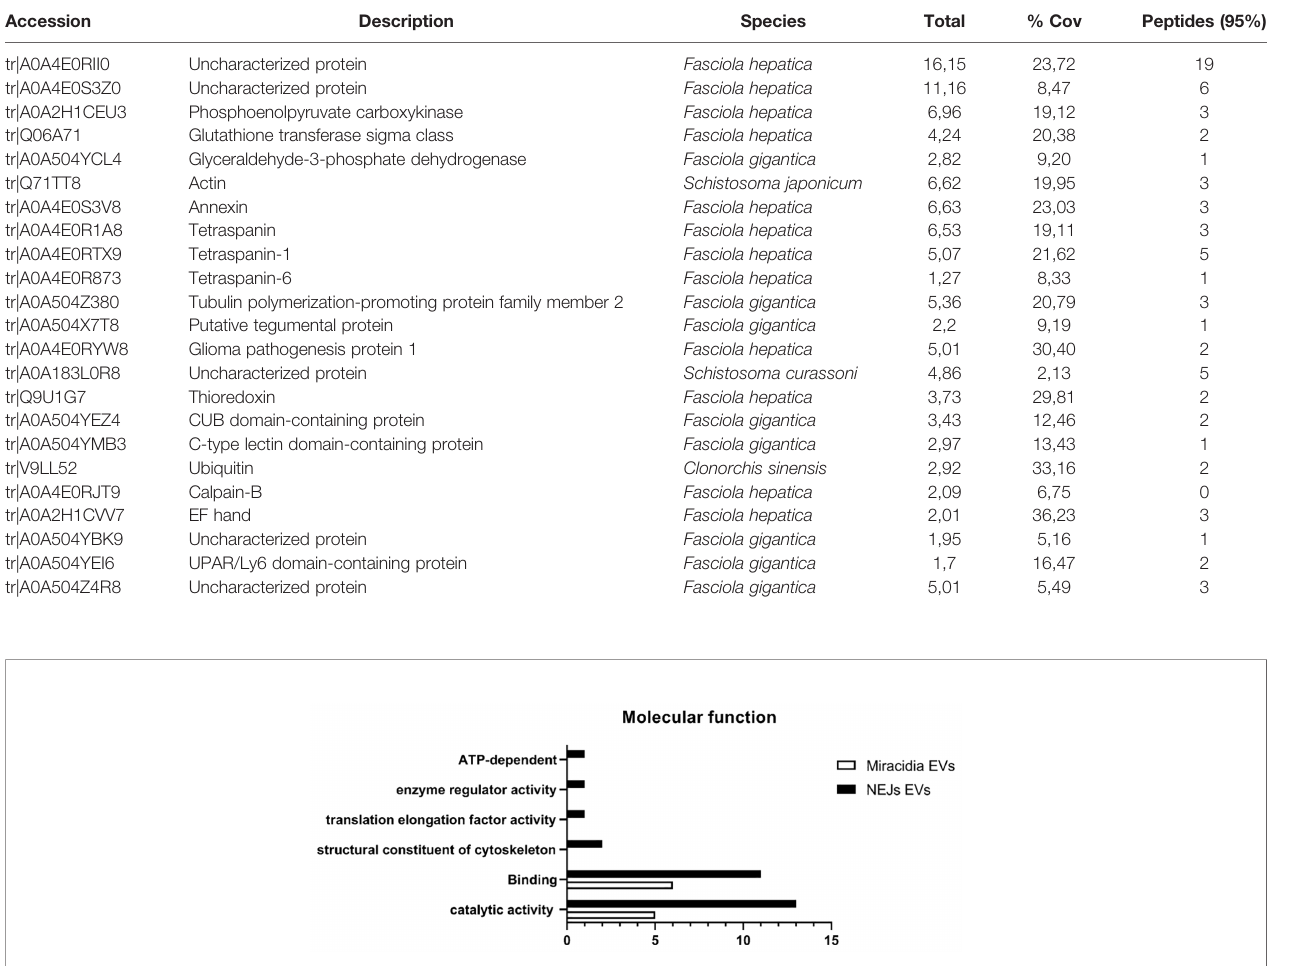
FIGURE 2 | Number of identi fi ed proteins in the proteome of F. hepatica NEJs and Eggs/Miracidia distributed according to the molecular functions (Gene Ontology, GO, level